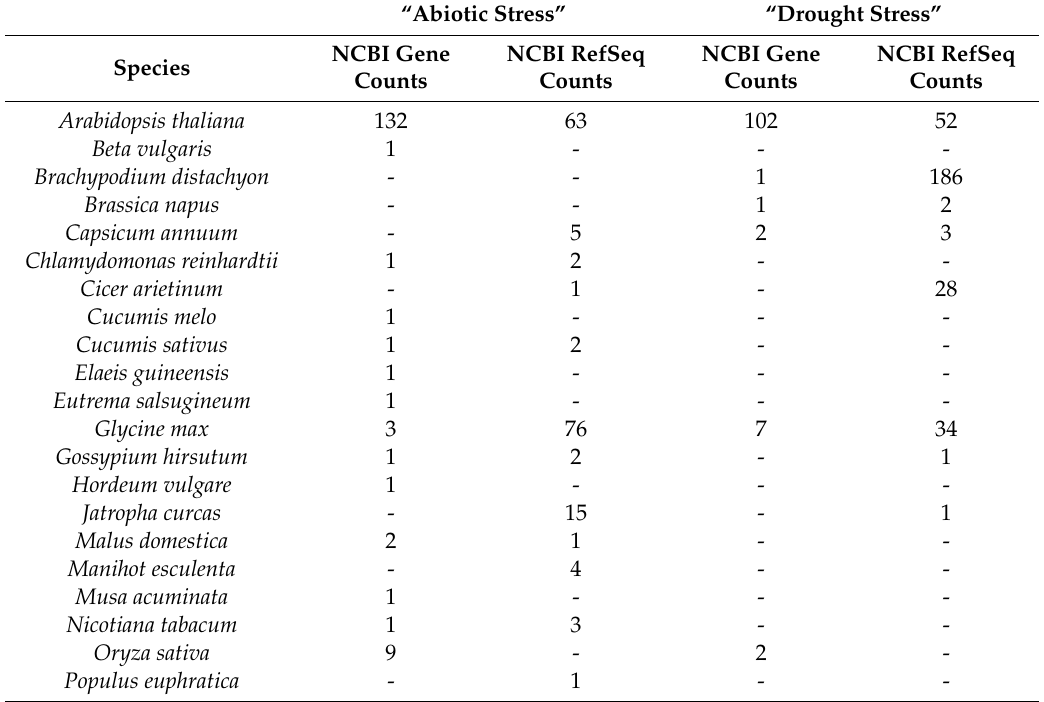
Table 2. Summary of genes including “abiotic stress” and “drought stress” in their functional annotation in NCBI Gene and in RefSeq